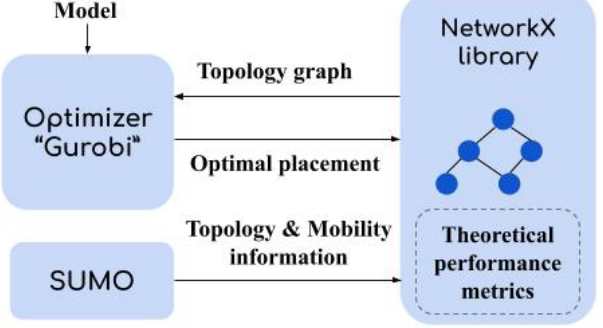
Figure 5. Used setup based on theoretical